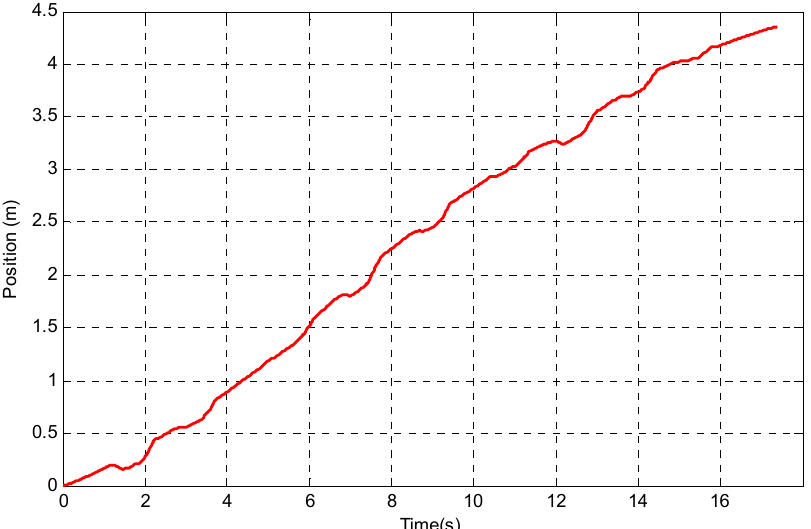
Figure 4. Errors in position tracking using DR algorithm for NHPT.